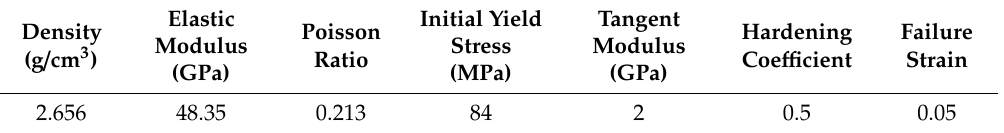
Table 2. Dynamic parameters of the sandstone.